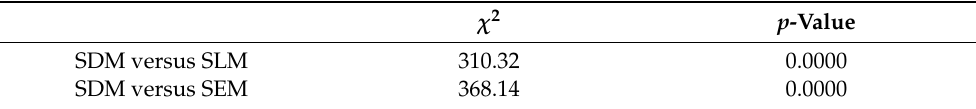
Table 3. Model selection.